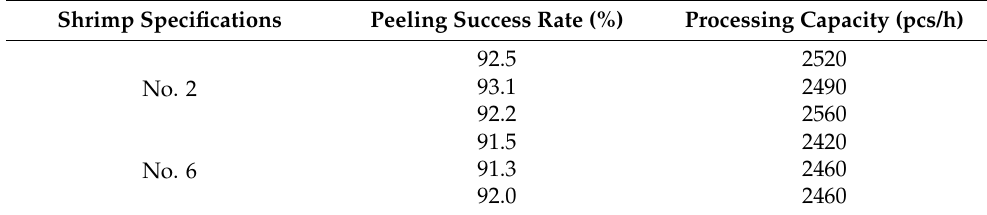
Table 2. Performance test results.